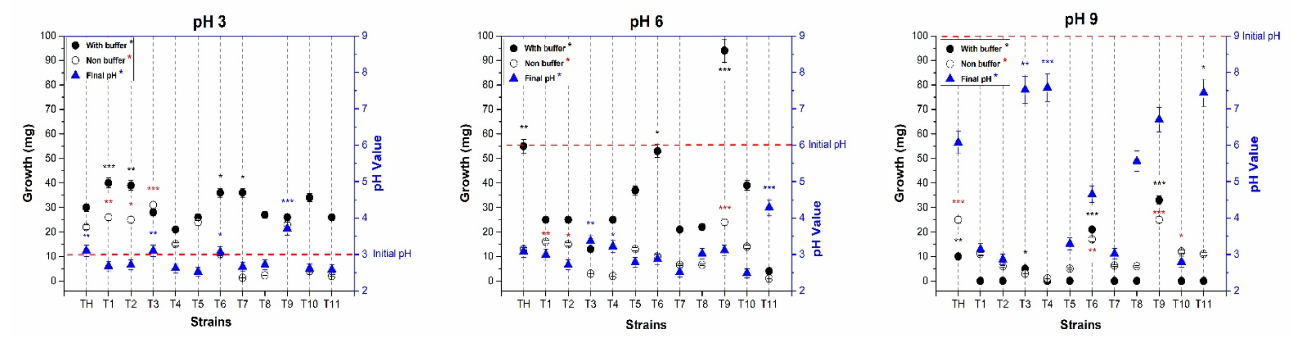
Figure 2. Diversity of the growth of Trichoderma in an extreme pH. Biomass production in acidic, neutral and alkaline pH conditions changes the affected strains in 0.2 × MS. The test consisted of three independent experiments and bars indicate standard deviations. The means marked with ***, ** and * are significantly different in each item designated for p < 0.05 in Tukey’s